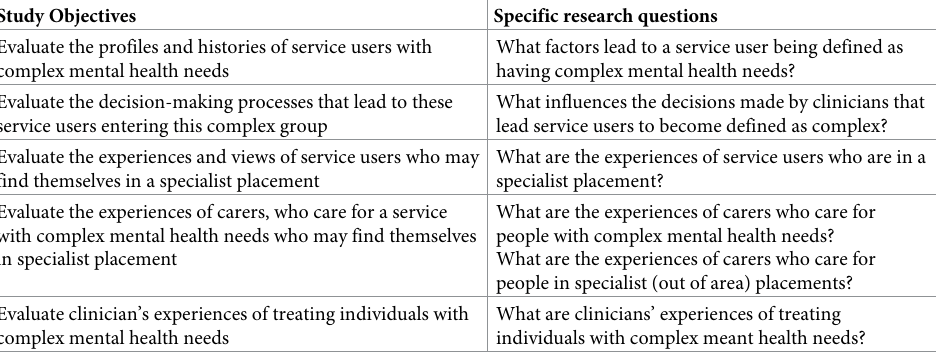
Table 1. Study objectives and research